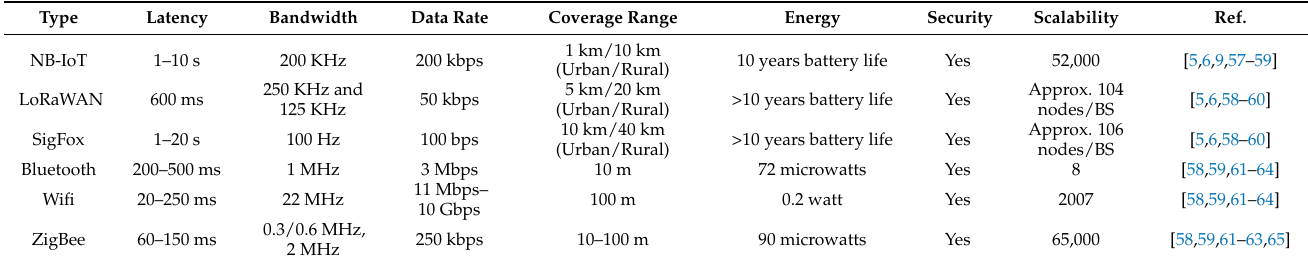
Table 3. Common IoT/IIoT wireless communication